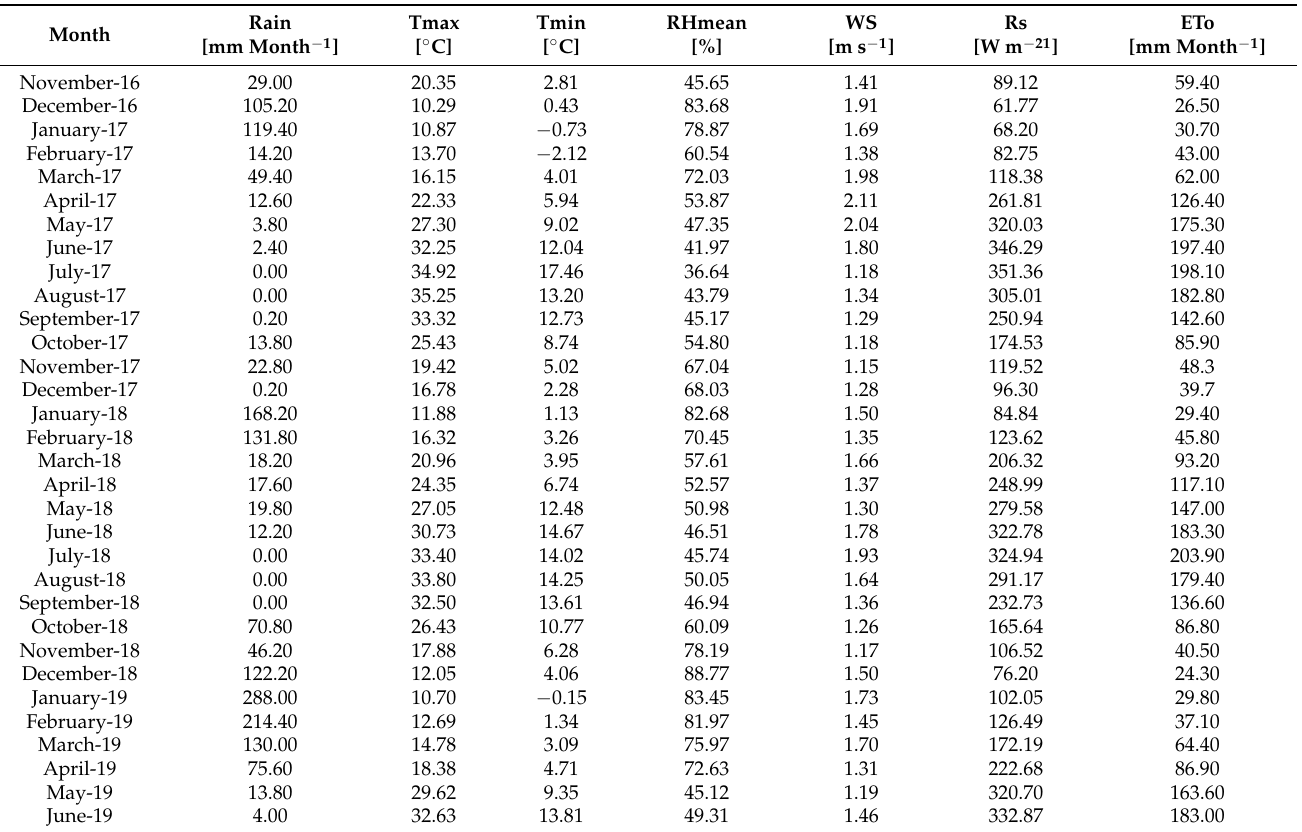
Table 1. Monthly climatic data as recorded from November 2016 until June